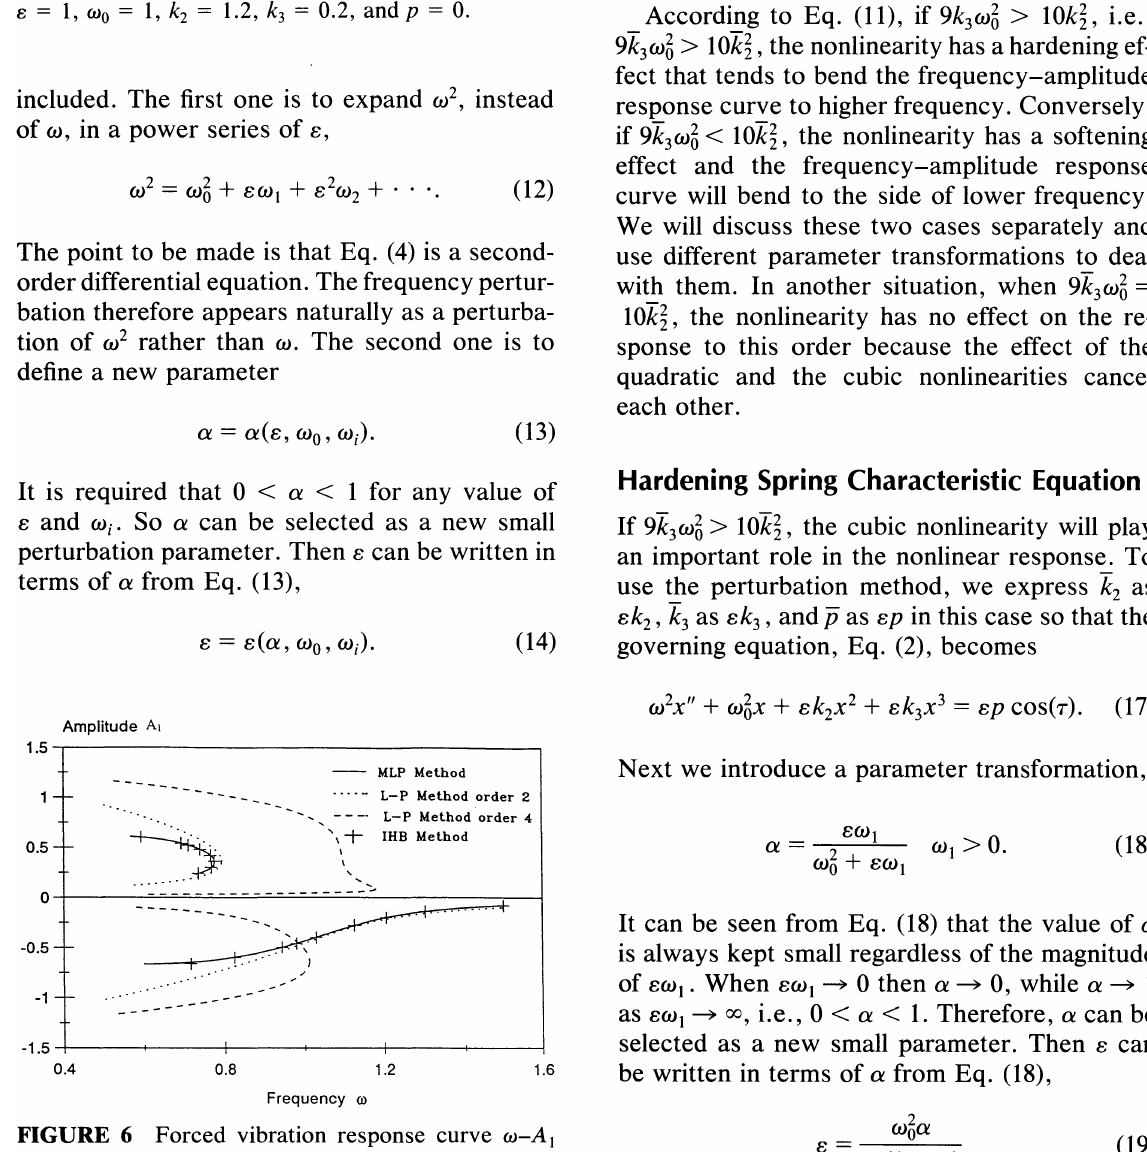
FIGURE 5 Free vibration response curve w-A I for e = 1, Wo = 1, k2 = 1.2, k3 = 0.2, and p =